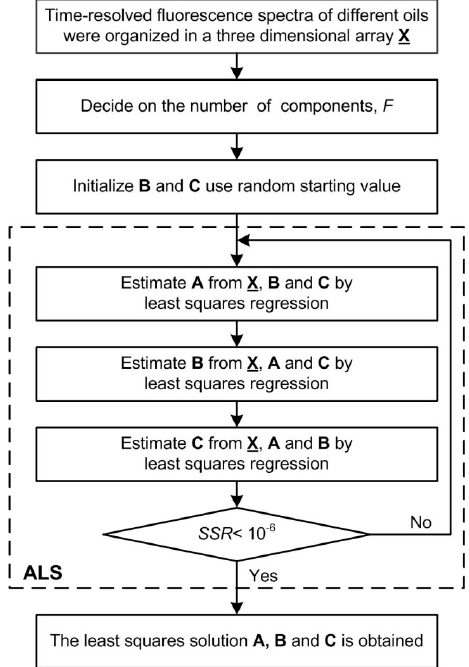
Figure 3. The flowchart of parallel factors analysis (PARAFAC) method used to decompose the time-resolved fluorescence spectra of oil samples.